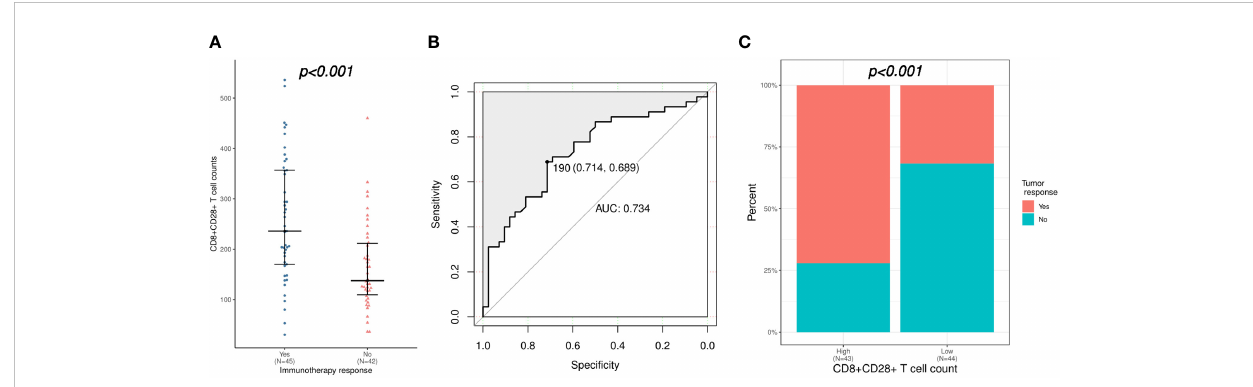
FIGURE 1 Correlation of CD8+CD28+ T-cell count with the immunotherapy response. (A) Comparison of CD8+CD28+ T-cell counts between immunotherapy responders and nonresponders. (B) Validation of the predictive value of the CD8+CD28+ T-cell count for immunotherapy response using an ROC curve. (C) Comparison of immunotherapy response between patients with high ( ≥ 190 cells/ m L) and low (< 190 cells/ m L) CD8+CD28+ T-cell counts. ROC, receiver operating